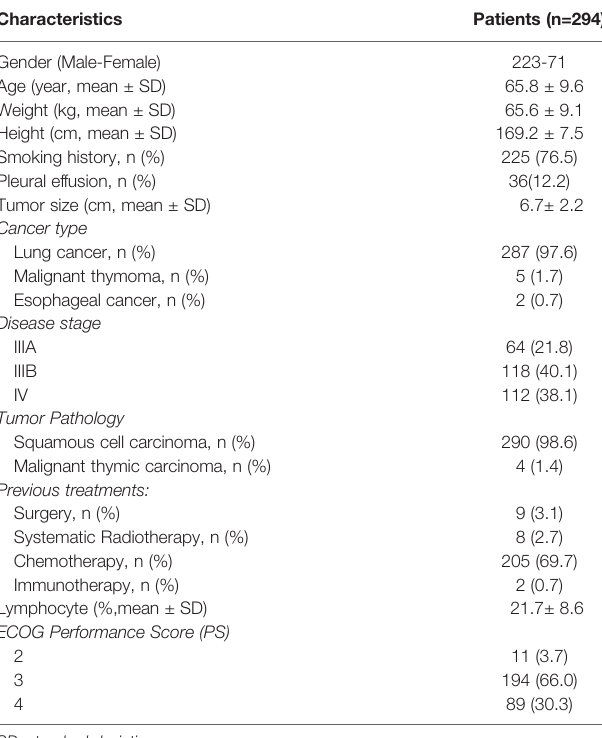
TABLE 1 | Clinical and demographic characteristics of patients at baseline. Characteristics